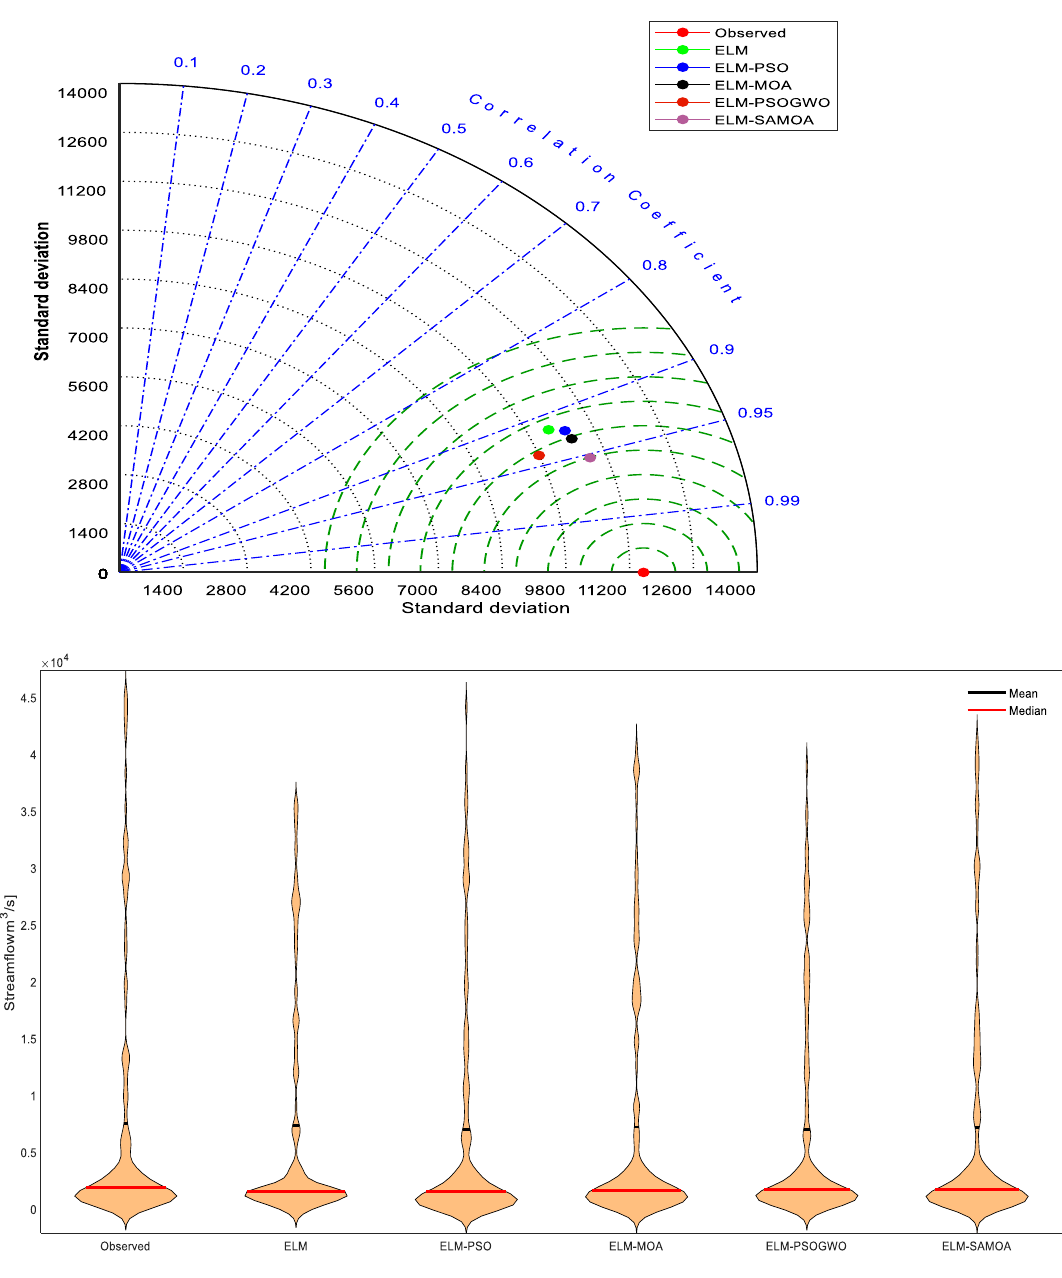
Fig. 9 Taylor and violin diagrams of different ELM-based models in the test period of Padma